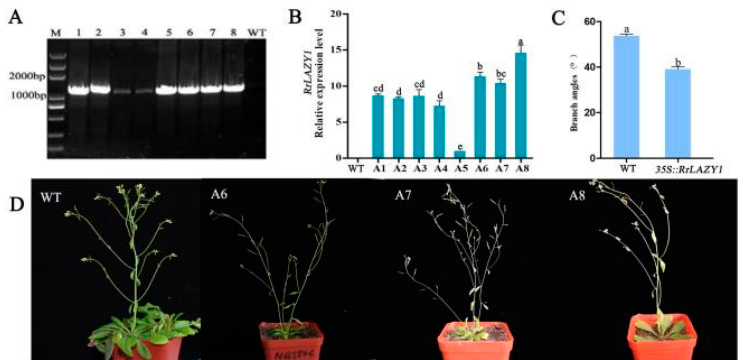
Figure 4. Analysis of Arabidopsis lines overexpressing the RrLAZY1 gene. ( A ) PCR identification of RrLAZY1 overexpression and wild-type Arabidopsis plants; ( B ) the results of the qRT-PCR detection of transgenic Arabidopsis lines; ( C ) inflorescence branch angle of transgenic Arabidopsis; Different lowercase letters indicate significant differences at p < 0.05. ( D ) phenotypes resulting from the overexpression of RrLAZY1 in Arabidopsis.